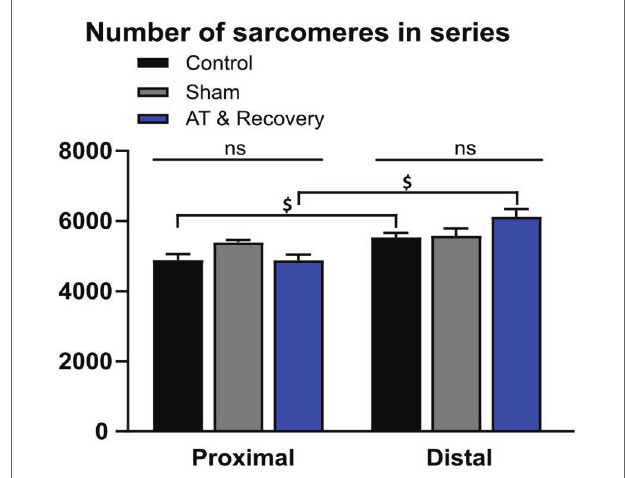
FIGURE 4 | Effects of aponeurotomy plus recovery from aponeurotomy on the number of serial sarcomeres within muscle fibers. (1) Treatment differences. In the aponeurotomized plus recovered GM, the number of sarcomeres in series was similar to that of the control group (straight lines above the bar graphs indicate that both proximally and distally located fibers, the serial sarcomere numbers were similar between treatments) ( p = 0.179). This may indicate either a lack of adaptation number of serial sarcomeres within distal muscle fibers or two opposing effects approximately compensating for each other (i.e., local protein degradation at one end and synthesis at the other end of the same muscle fiber). (2) Differences in the number of sarcomeres in series within muscles (proximal vs. distal fibers differences). Within muscle differences are indicated with “$.” Distal muscle fibers of the aponeurotomy plus recovery group and control group had more serial sarcomeres compared to proximal fibers ( p = 0.001 and p = 0.017, respectively). It is unknown why in the sham proximal and distal fibers, the number of sarcomeres in series is similar, as from literature it is known that in GM distal fibers have higher numbers of sarcomeres in series. A two-way mixed ANOVA was used to check for differences in serial sarcomere number between treatments and within muscle location (proximally vs. distally located fibers). All values are presented as mean and plus SEM; control n = 10, sham n = 6, AT & recovery n = 6.